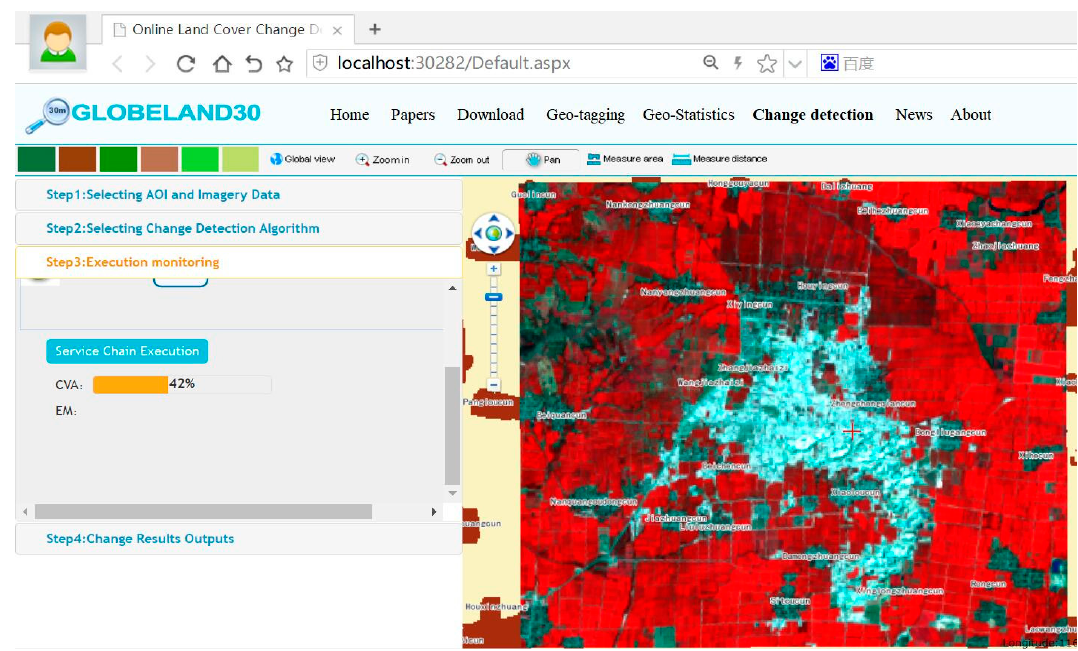
Figure 9. Monitoring of the execution of a change detection service chain.